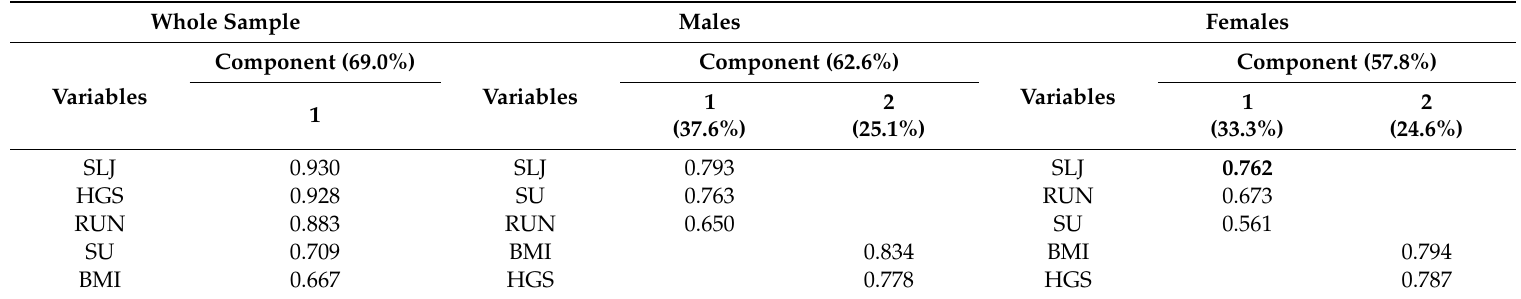
Table 3. Principal component analysis for measured physical fitness